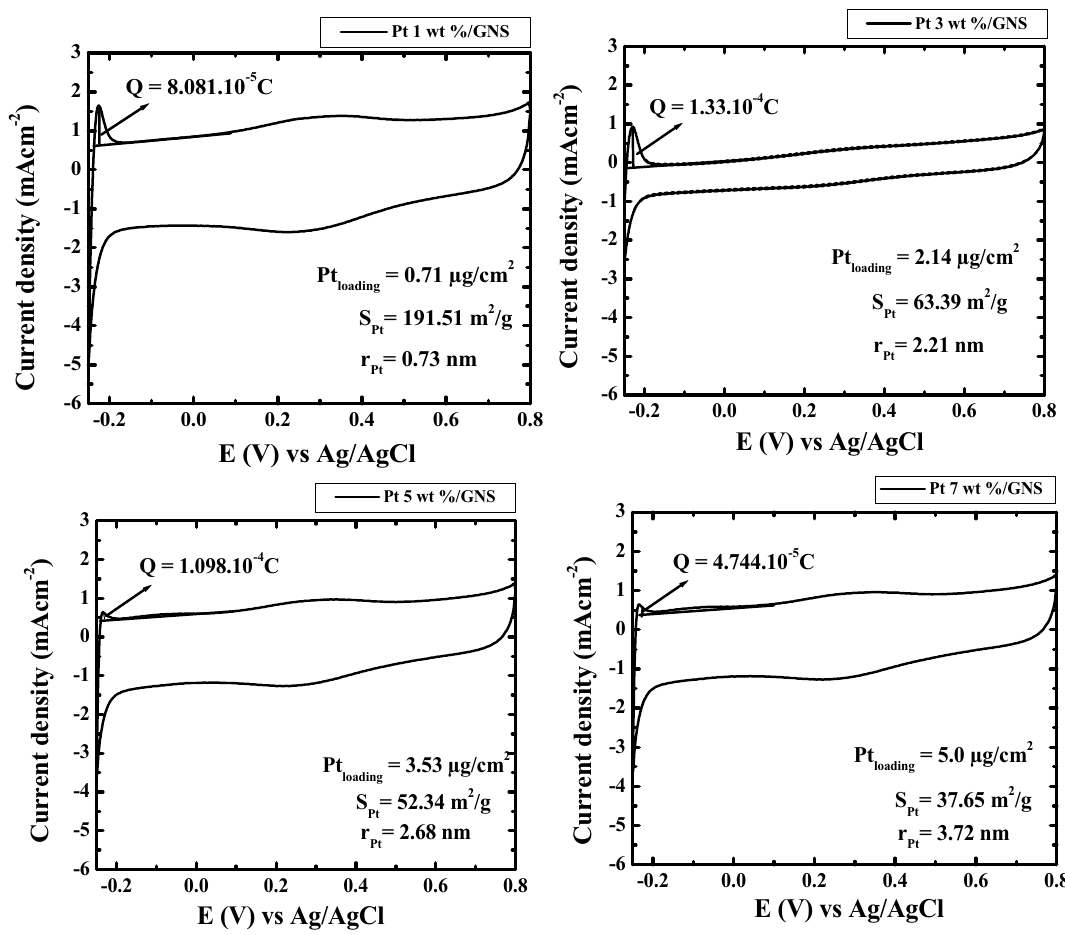
Figure 11. Polarization curves of ECSA H for 1–7 wt.% Pt/GNS on a rotating disk electrode (RDE) measured in 0.1 mol dm −3 HClO 4 at 60 °C, where H 2 gas is bubbled. Rotating speed 500 rpm and scan rate 10mVs −1 between—0.20 and 0.1 vs